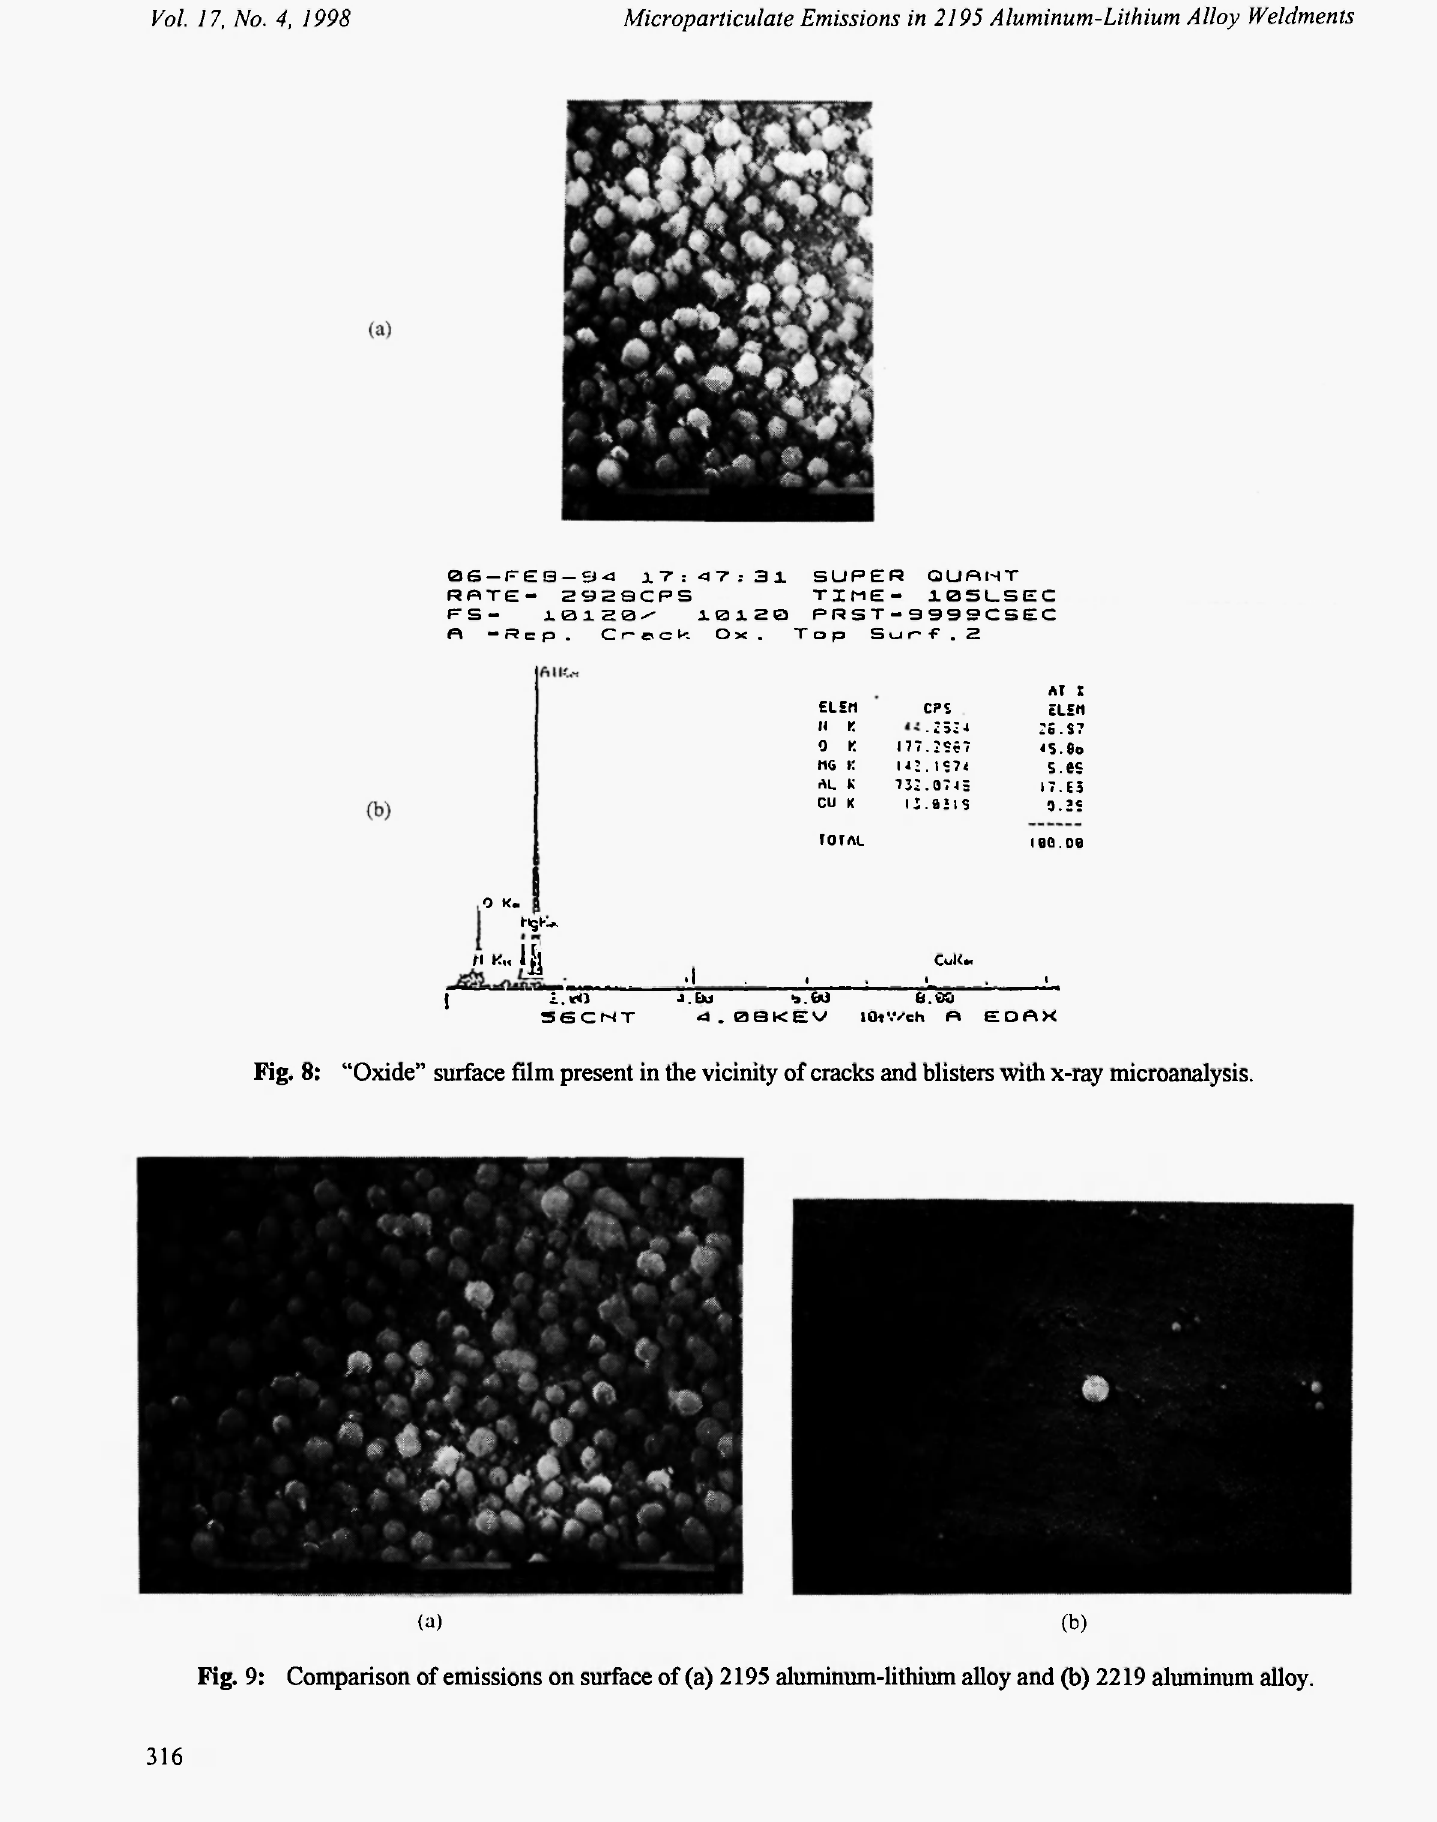
Fig. 9: Comparison of emissions on surface of (a) 2195 aluminum-lithium alloy and (b) 2219 aluminum alloy.